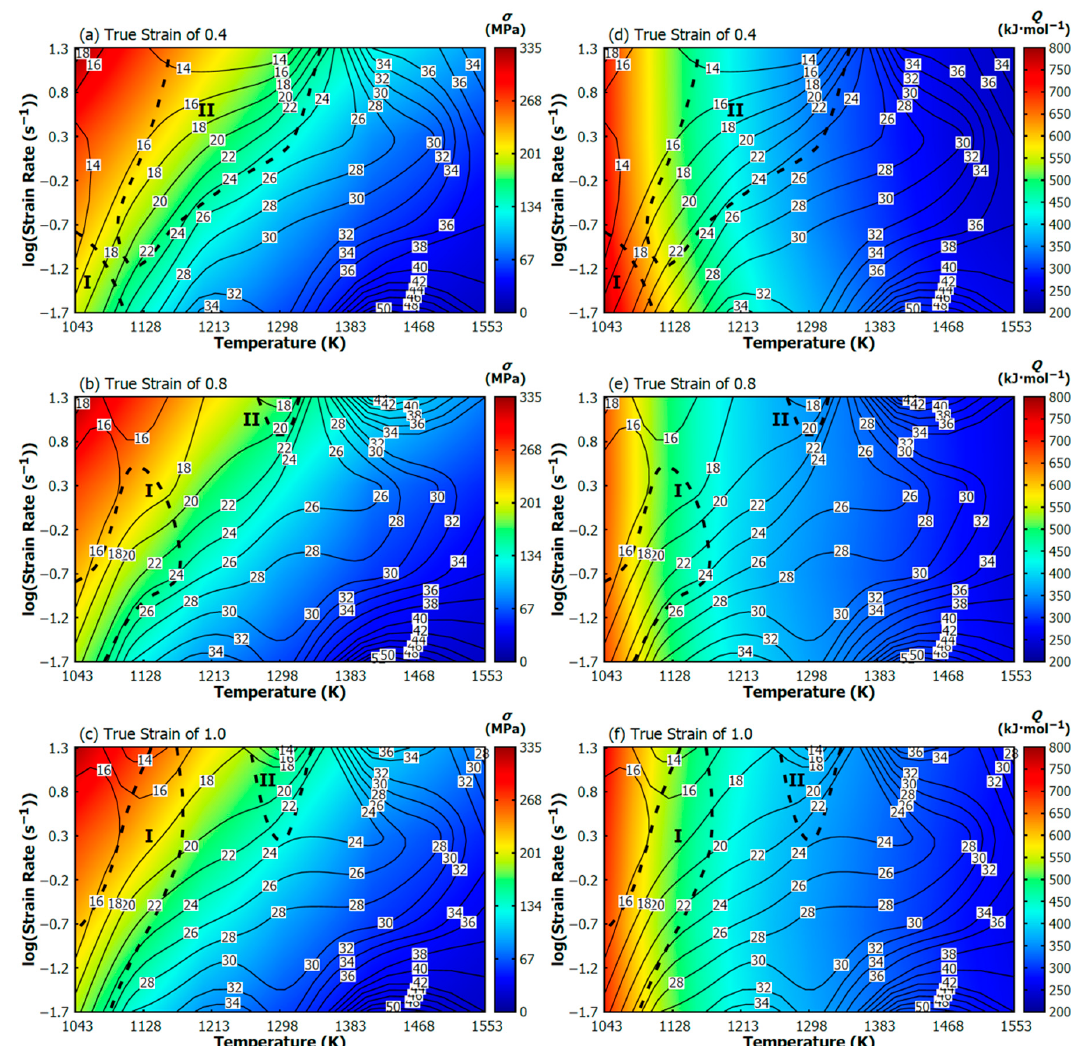
Figure 5. Processing maps of the investigated Cr-Mo low alloyed steel. ( a – c ) Conventional hot processing (CHP) maps superimposed by flow-stress (FS) maps; ( d – f ) activation-energy processing (AEP) maps. Solid contours with labels—power dissipation efficiency, dashed lines—districts of metallurgical instability, color background—flow stress evolution in ( a – c ) or activation energy evolution in ( d – f ).